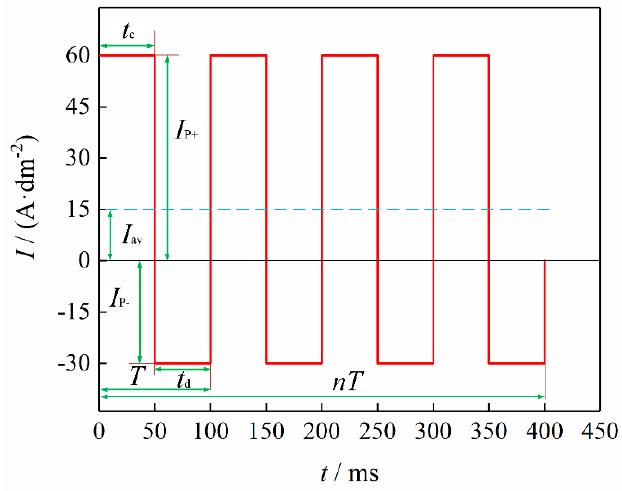
Figure 2. Schematic diagram of pulse waveform when I av = 15 A · dm 2 , λ = 0.5, x = 0.5, and f = 10 Hz.